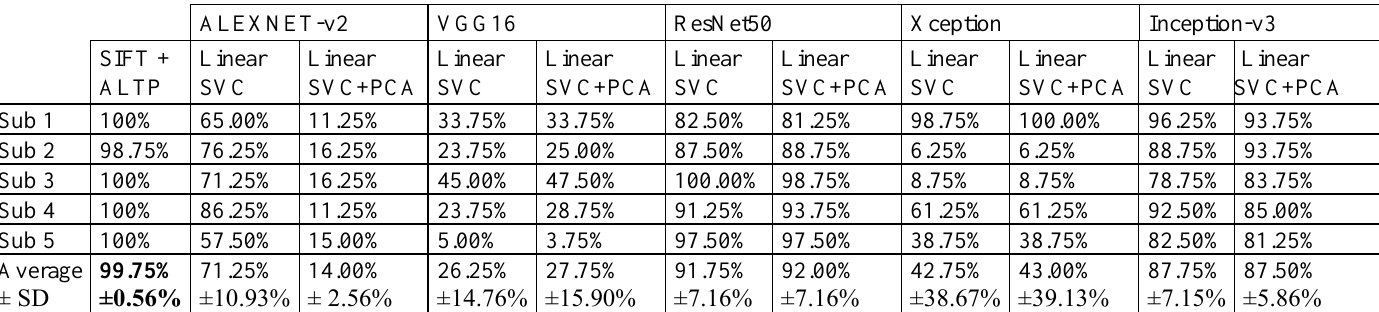
Table 2. Recognition accuracy ratio of SIFT + ALTP method and different deep learning models on the ORL database.